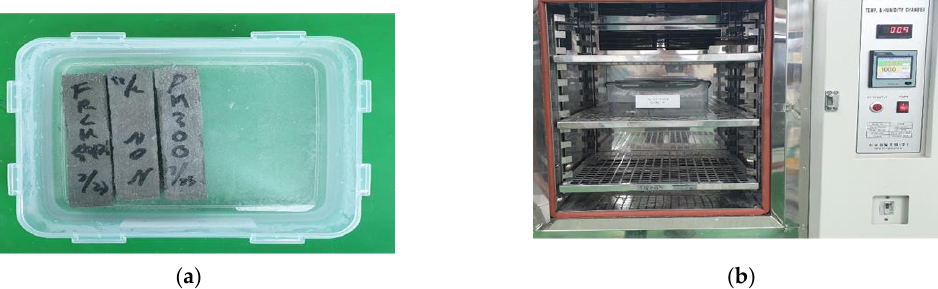
Table 2. Test results for the matrix.